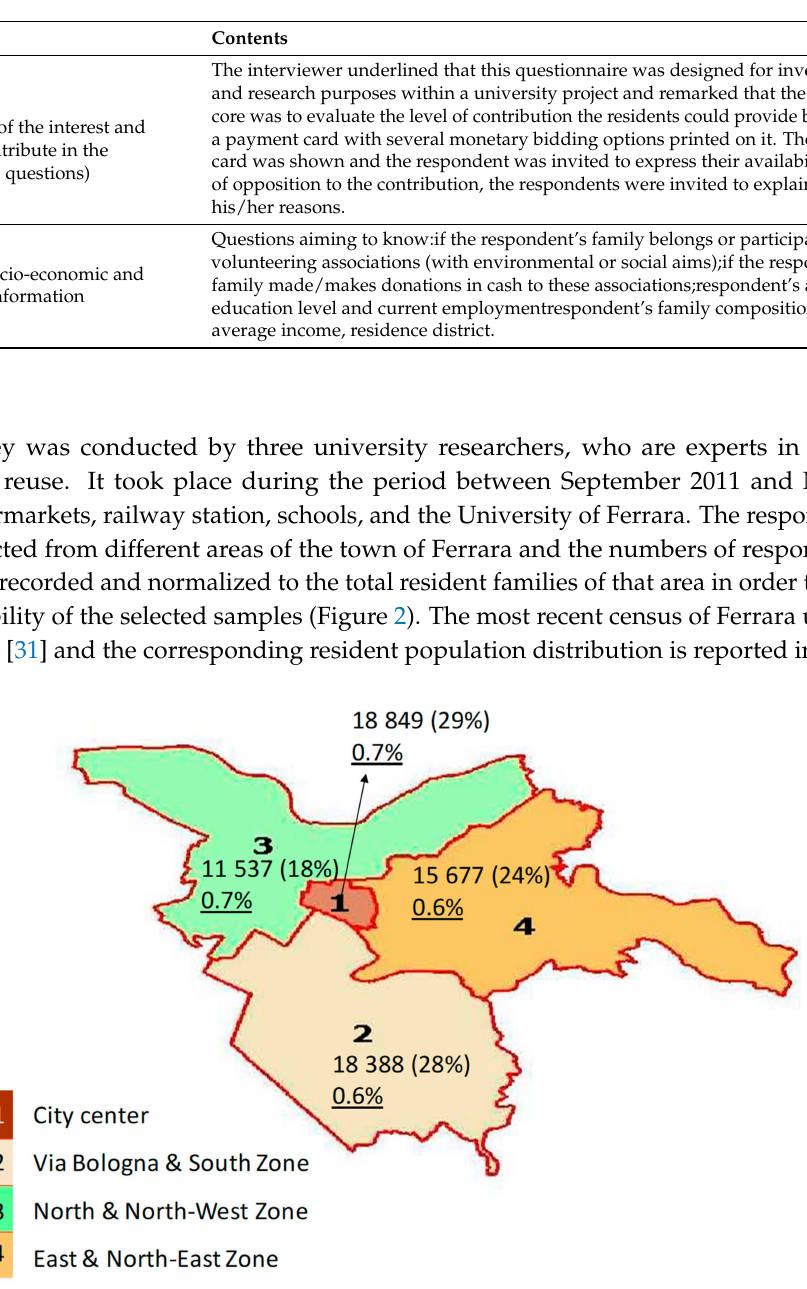
Figure 2. The four districts of Ferrara with the corresponding number of resident families and in brackets the percentage of the total and underlined the percentage of respondent families involved in the